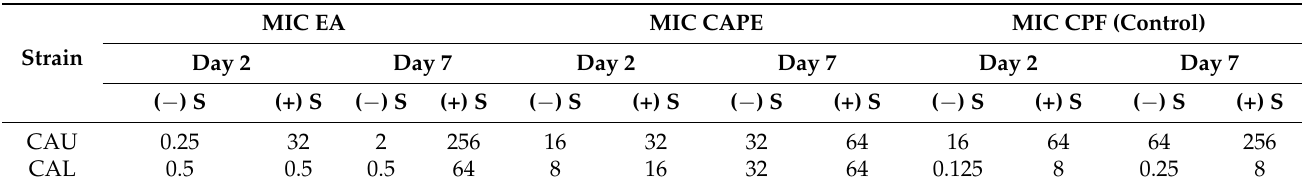
Table 2. MIC values ( µ g/mL) of EA, CAPE and caspofungin against C. auris CAU-04 and C. albicans SC5314 and in the presence (+) and absence ( − ) of sorbitol (S).